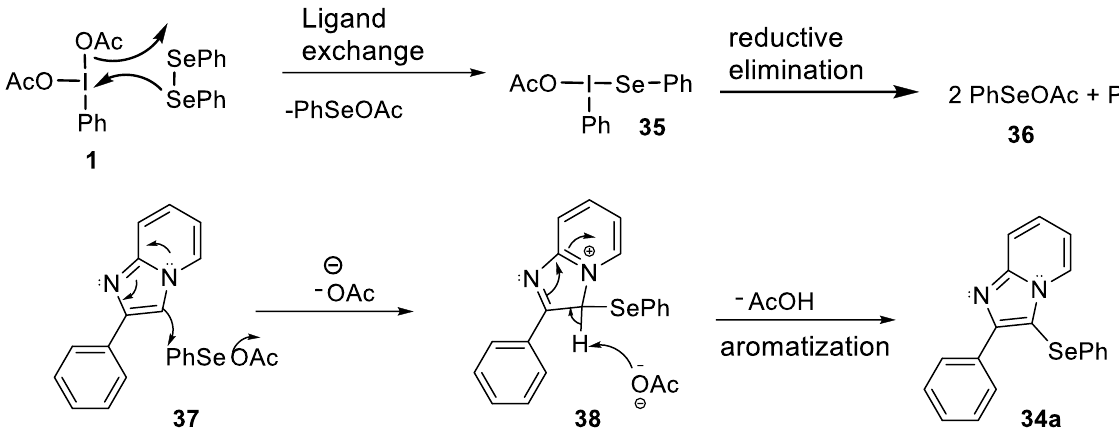
Figure 6. PIDA-mediated plausible mechanism for the phenylselenation.